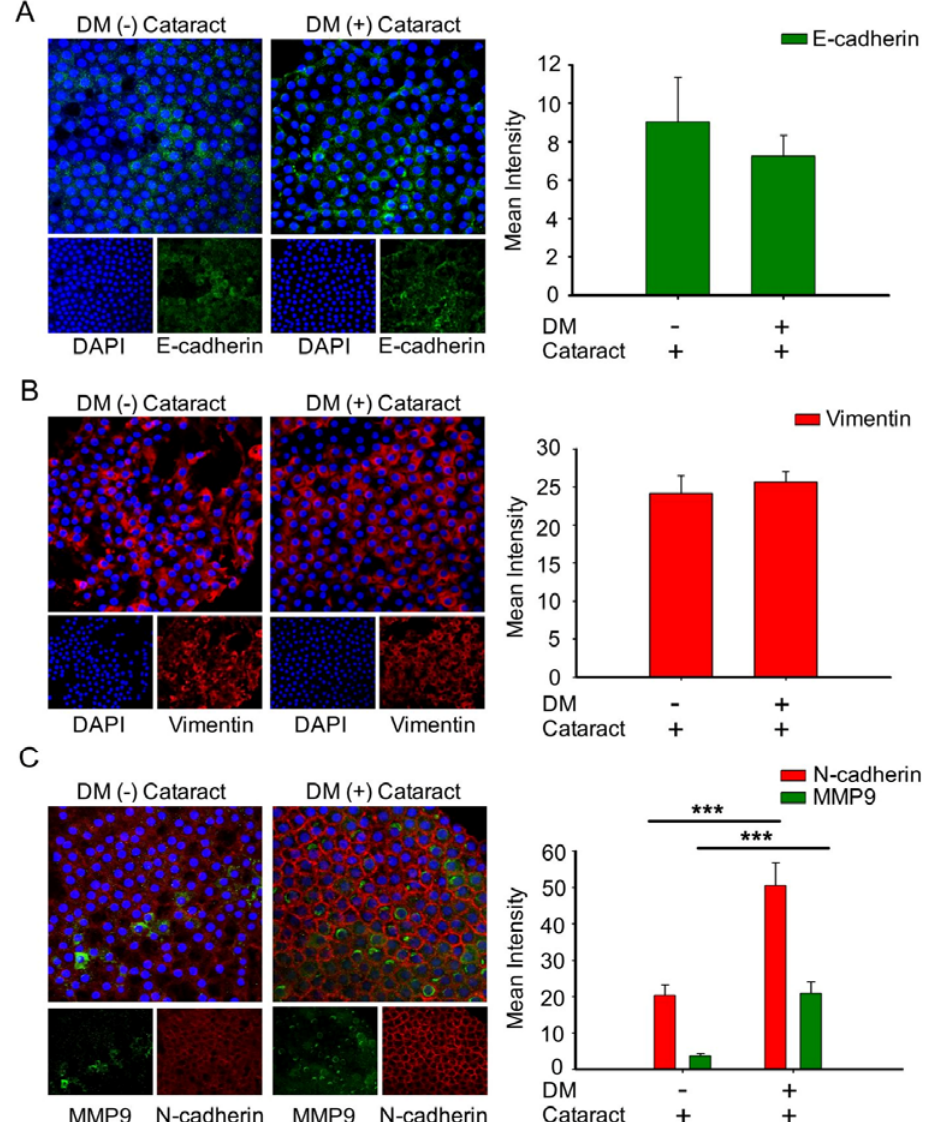
Figure 4. Cataracts induced epithelial–mesenchymal transition (EMT) progression with significantly elevated N ‐ cadherin and MMP9 expression in DM (+) patients. ( A ) Representative green fluorescence images of E ‐ cadherin and ( B ) red fluorescence images of vimentin ‐ positive cells in human lens epithelial sections from DM (+) or DM ( − ) cataracts. ( C ) MMP9 (green) and N ‐ cadherin (red) were both upregulated in DM (+) cataract patients compared to DM ( − ) cataract patients. Lens cell nuclei were counterstained with DAPI (blue). Presented values are means ± SEMs ( n = 10 per group, separate experimental groups in each figure). *** p < 0.001.